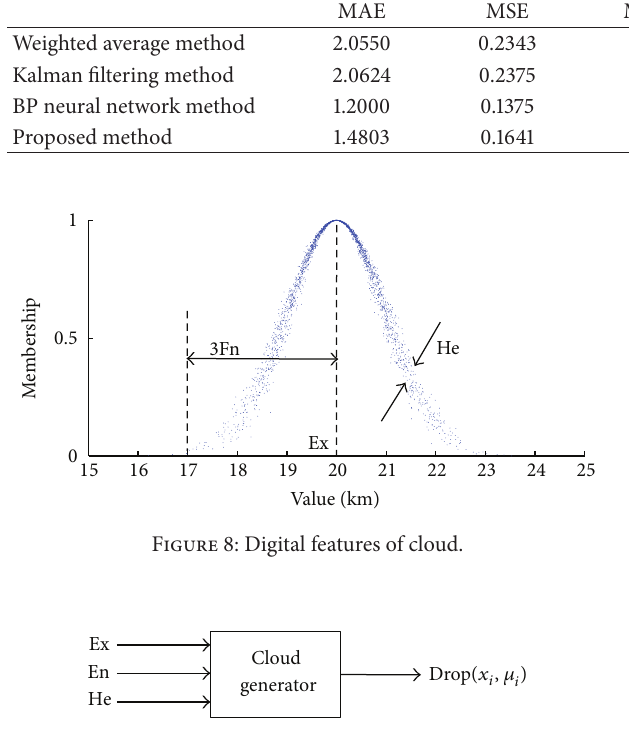
Figure 9: Forward cloud